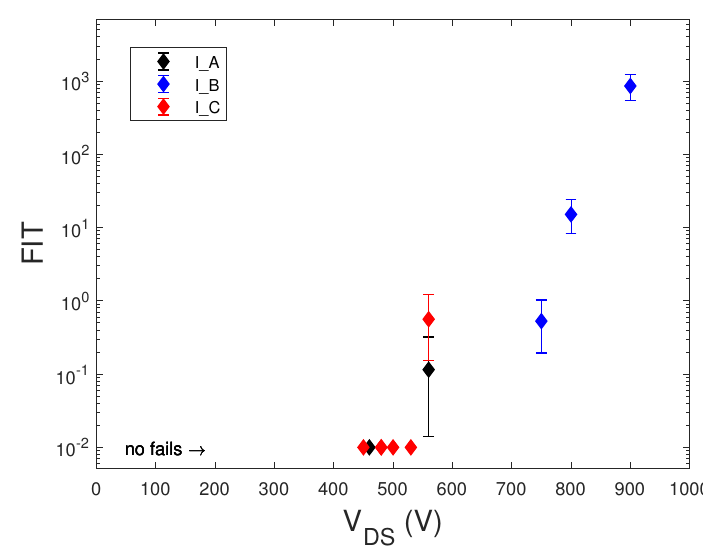
Figure 7. Measured FIT data at sea level of the STMicroelectronics